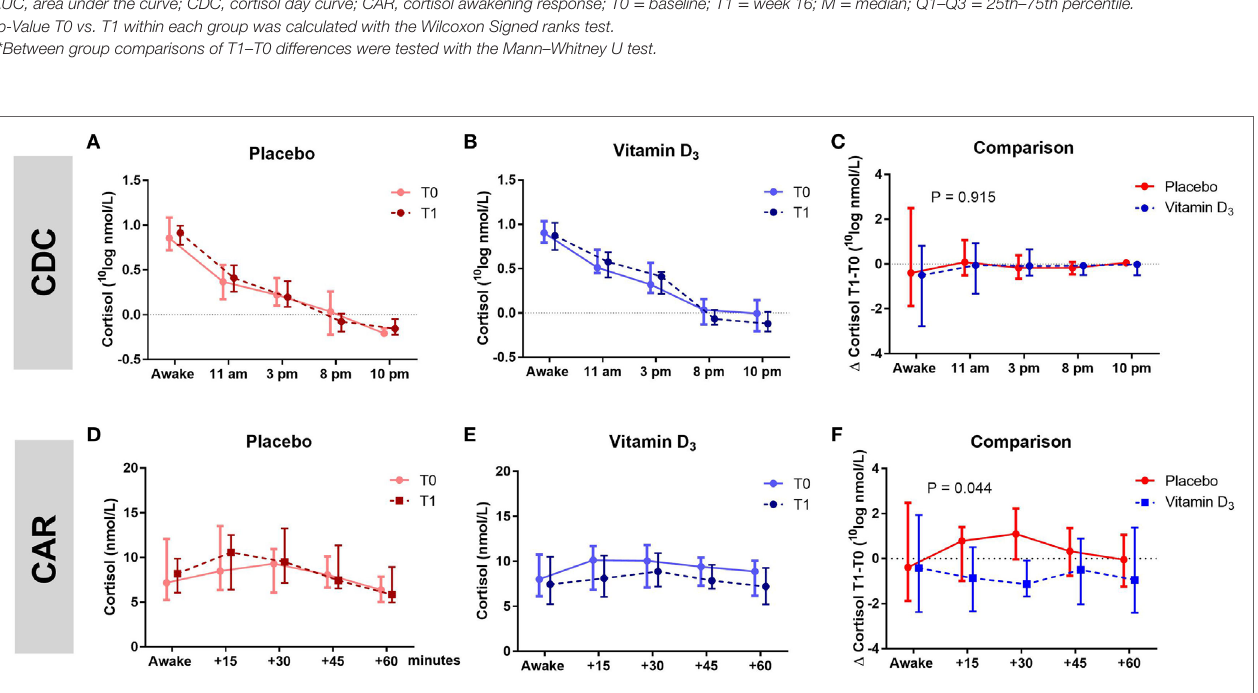
FigUre 3 | Association of vitamin D 3 supplements with HPA-axis activity. Within group comparisons of the cortisol day curves (CDC) at T0 (baseline) and T1 (week 16) in the placebo arm [ (a) ; n = 19] and in the vitamin D 3 arm [ (b) ; n = 21], and within group comparisons cortisol awakening responses (CAR) at T0 and T1 in the placebo arm [ (D) ; n = 19] and in the vitamin D 3 arm [ (e) ; n = 22]. Between group comparison for the CDC [ (c) ; T1–T0] and CAR [ (F) ; T1–T0]. Data-points show median values with corresponding interquartile ranges. p -Value shows difference in area under the curve between vitamin D and placebo group tested with the Mann–Whitney U test.